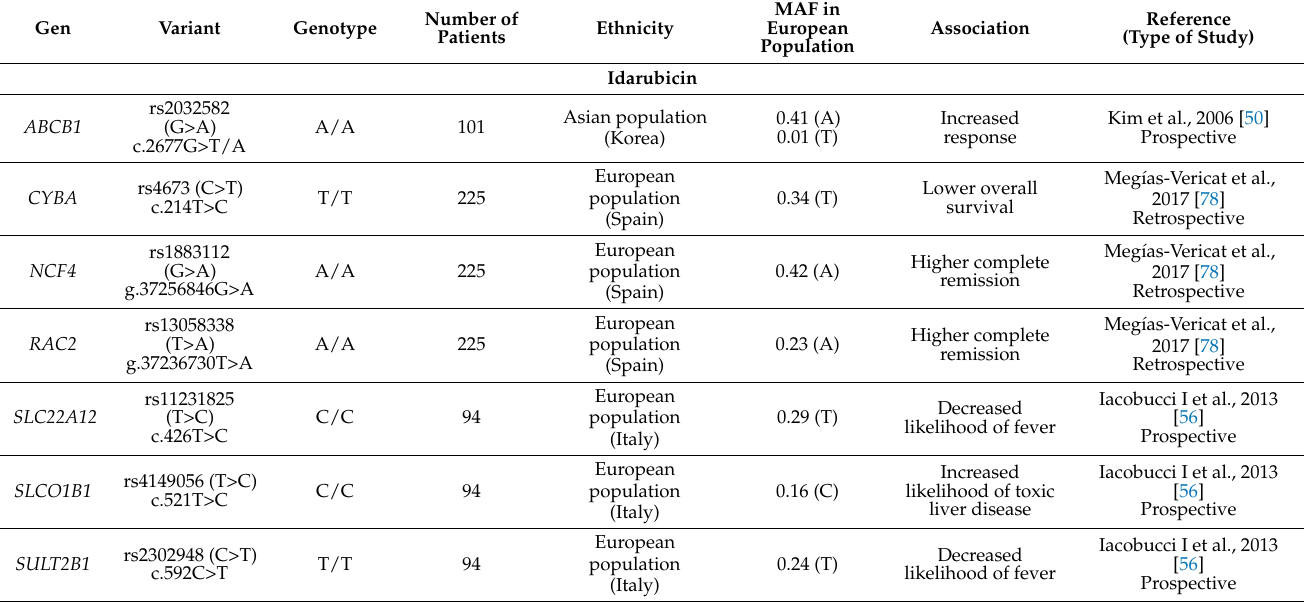
Table 2. Summary of the pharmacogenetic associations related to anthracyclines (idarubicin and daunorubicin) response in AML